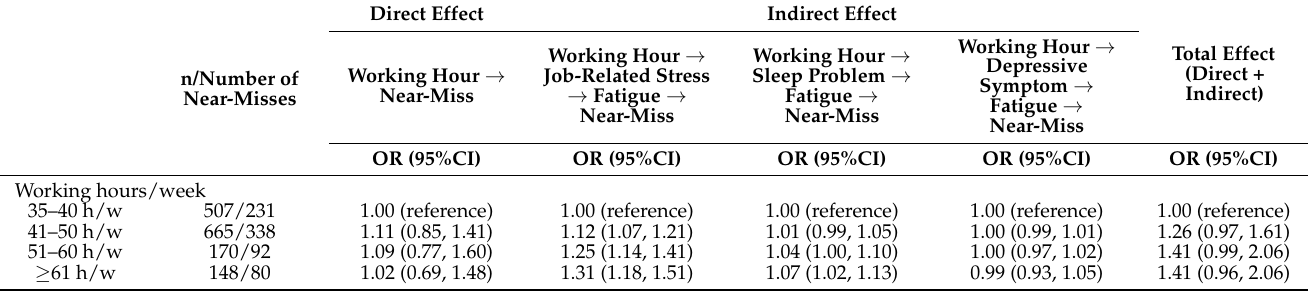
Direct, indirect, and total effects of working hours on near-misses during the past six months for healthcare